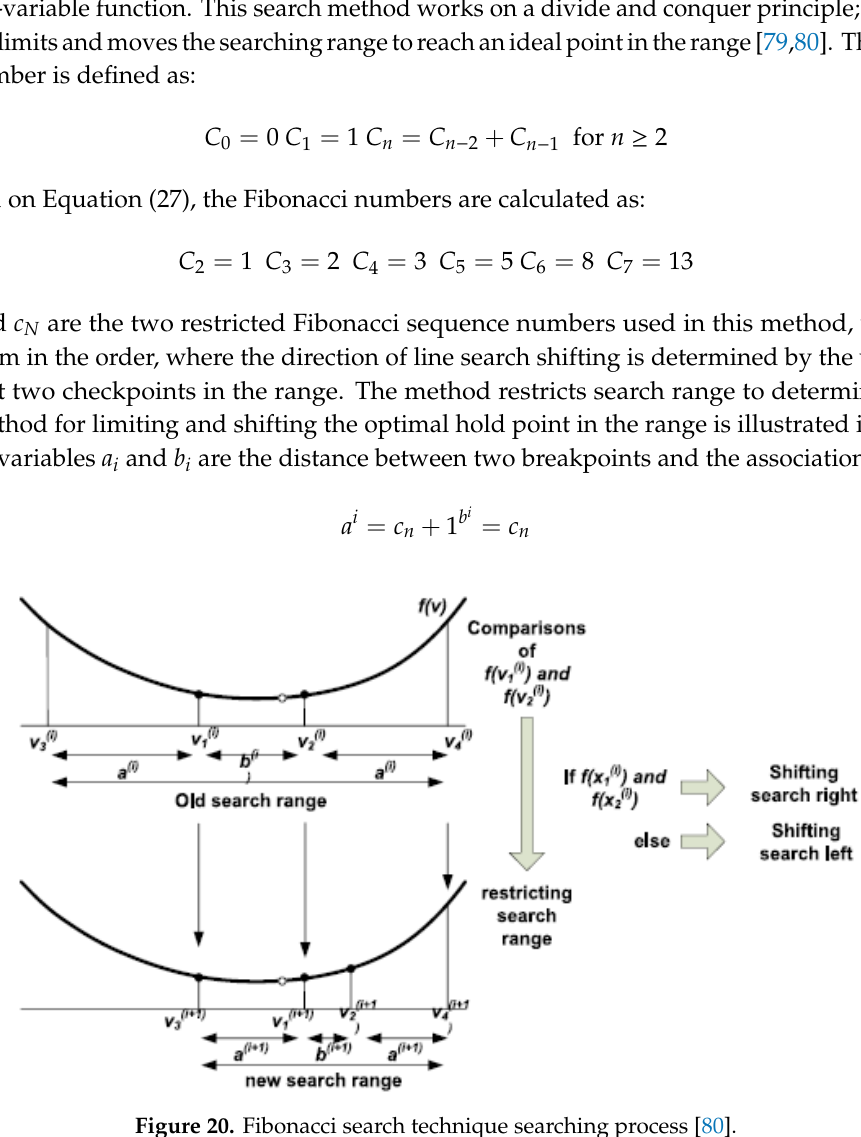
Figure 19. Cuckoo search under partial shading conditions [78].